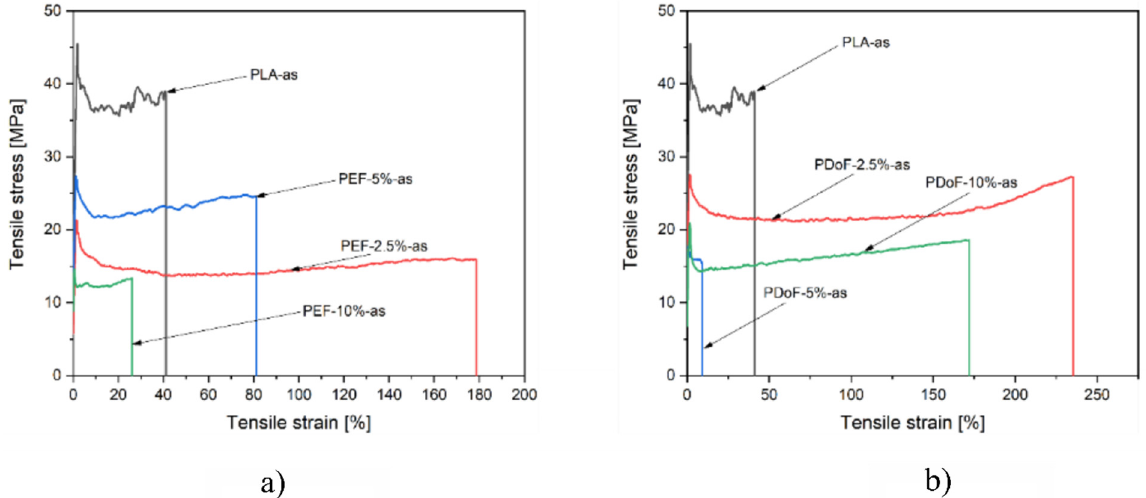
Figure 9. Representative stress–strain curves of the ( a ) PLA/PEF and ( b ) PLA/PDoF as − spun fiber